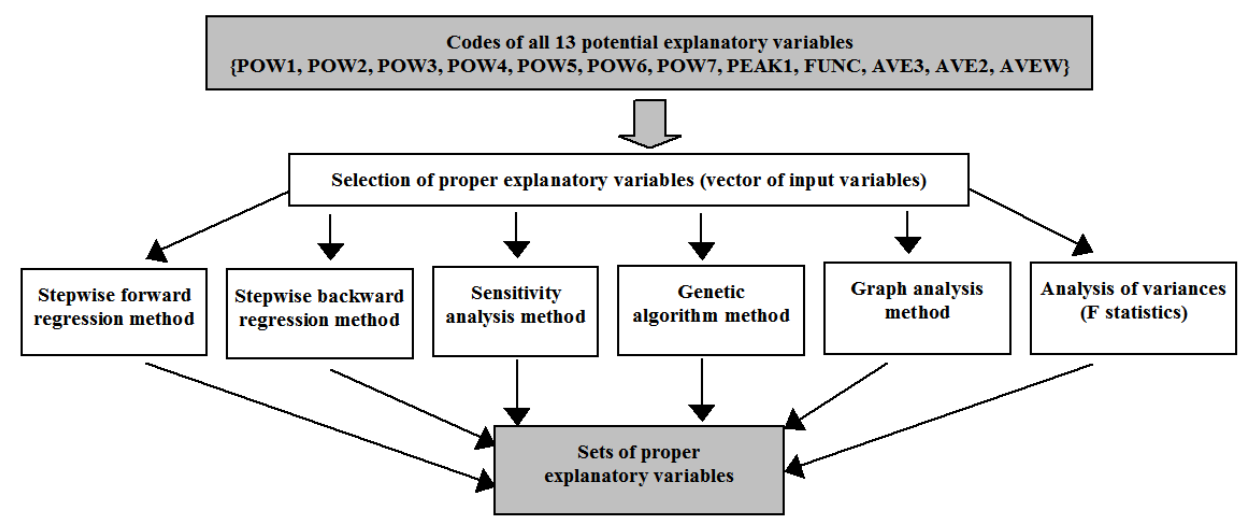
Figure 7. Scheme of selecting proper sets of explanatory variables.